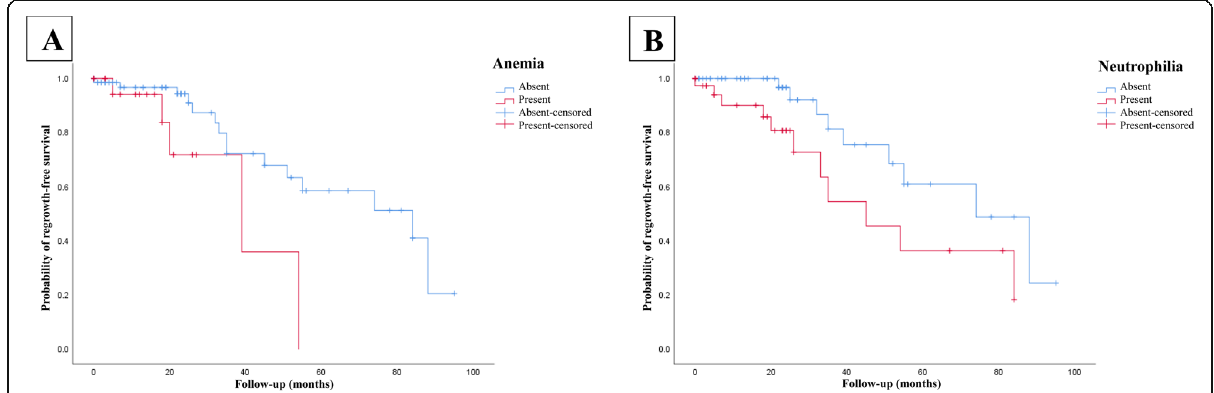
Fig. 2 Kaplan-Meier curve demonstrating recurrence-regrowth free survival in patients with ( A ) anemia and ( B )